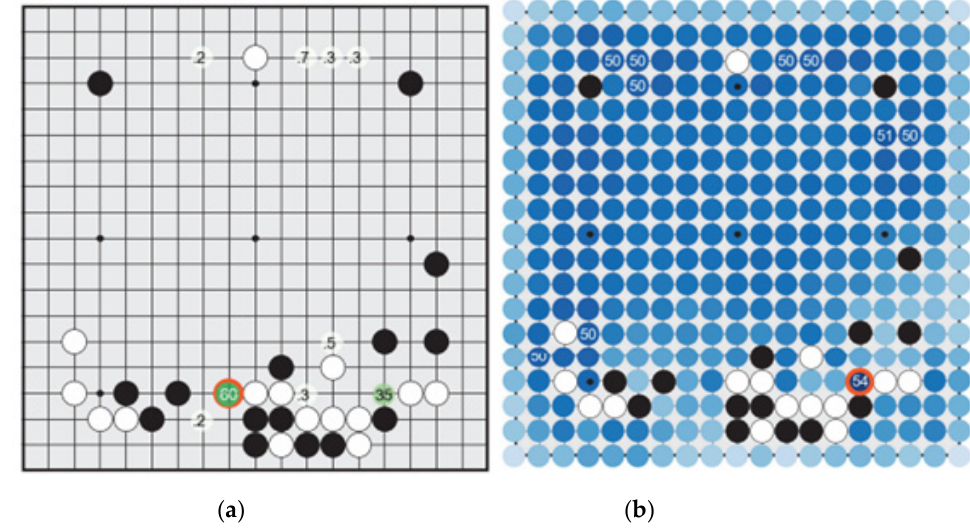
Figure 1. ( a ) Policy Network (Figure 5d in [15]). ( b ) Value Network (Figure 5a in [15]). Re-